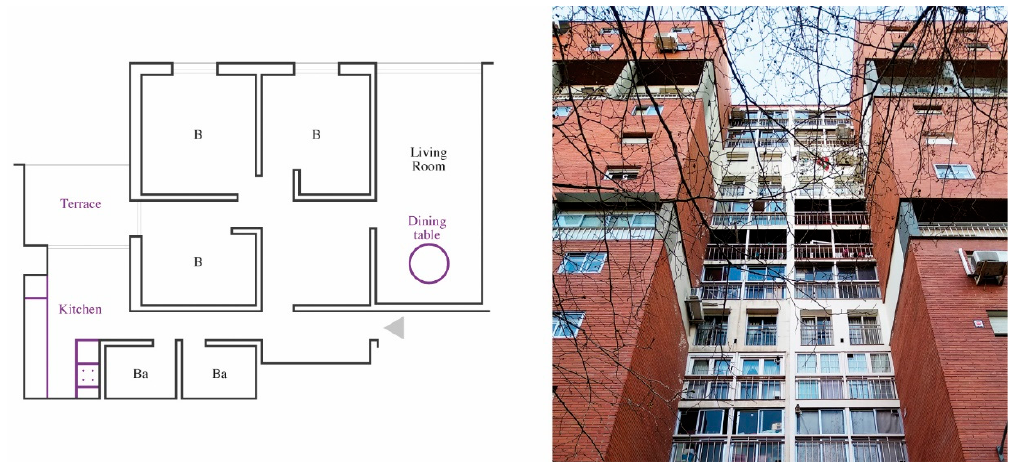
Figure 3. VSM (Viviendas Sociales de Madrid) housing in Palomeras Sureste, UD 3 mega-block. Three-bedroom “tower typology” apartment. Plan redrawn and photo by author.